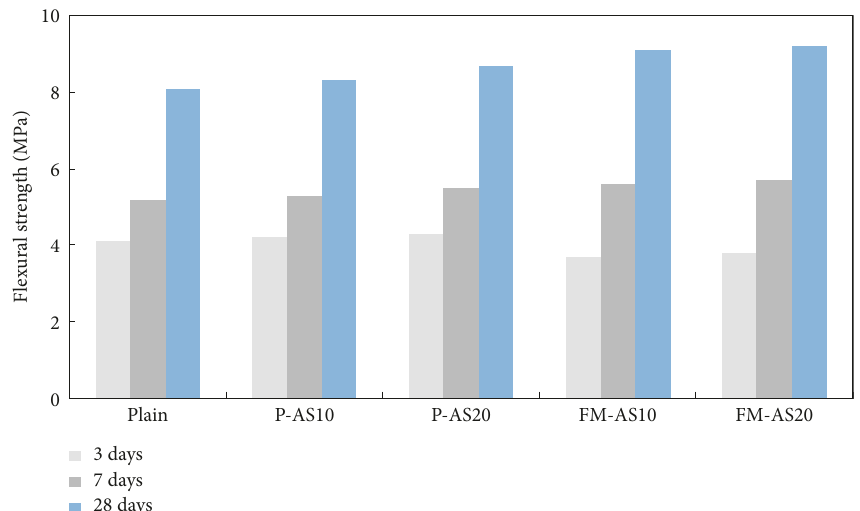
Figure 10: Flexural strength of cement mortar using atomizing slag-modified RMAP.